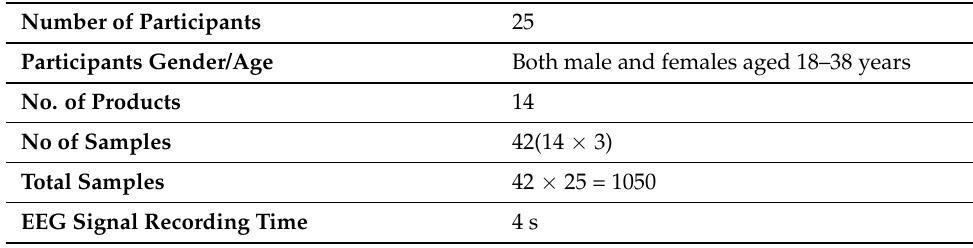
Table 2. Summary of neuromarketing